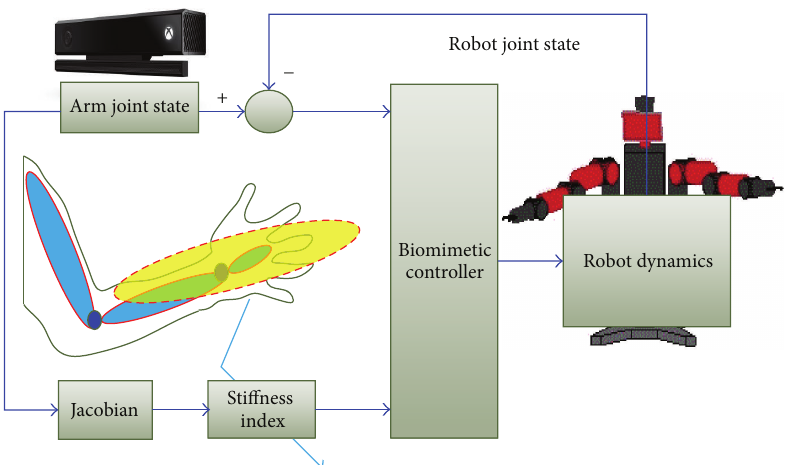
Figure 2: Profile of HRC in discrete-time. Human arm endpoint stiffness, forward kinematic, and postural stiffness are estimated in discrete- time and transfer to Baxter robot via biomimetic